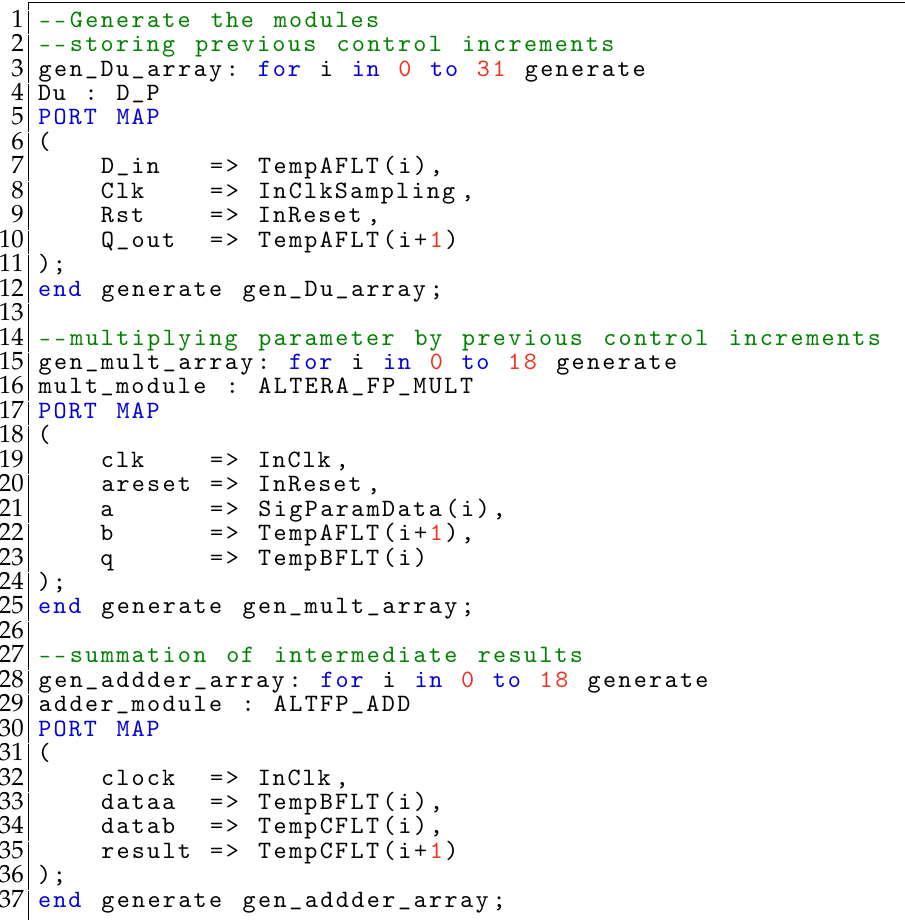
Figure 3. Code snippet in Verilog Hardware Description Language describing a set of automatically generated multipliers with